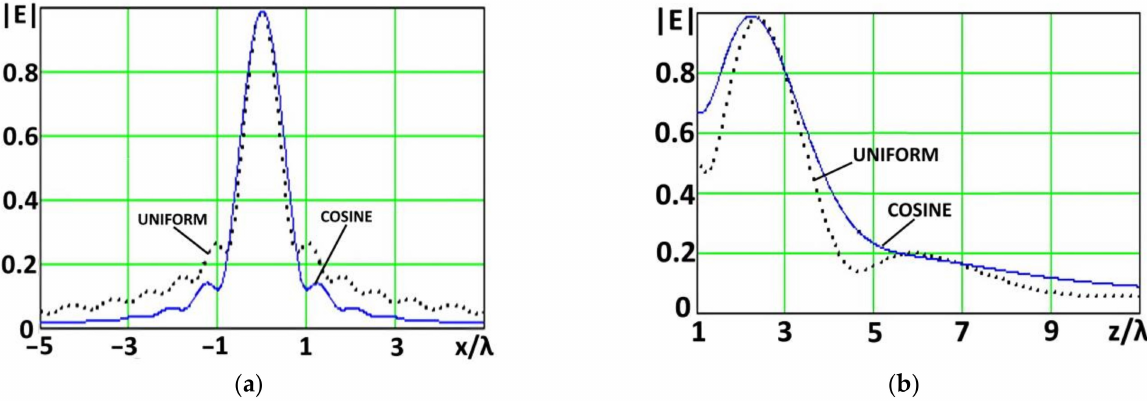
Figure 12. Distribution of the electric field strength module in directions ( a ) parallel and ( b ) per- pendicular to the aperture for uniform and cosine amplitude distributions L / λ = 10, focal length z 0 / λ = 2.5